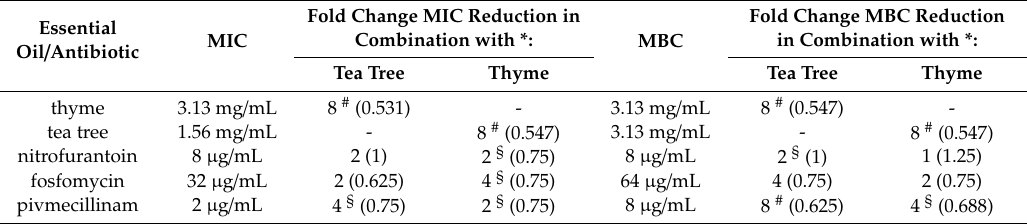
Table 3. Minimum inhibitory and bactericidal concentration (MIC / MBC) against four E. coli strains $ in artificial urine of tea tree and thyme essential oils, fosfomycin, nitrofurantoin, and pivmecillinam, alone and fold, change MIC / MBC reduction in combination with tea tree or thyme essential oil. Median values from three independent measurements are